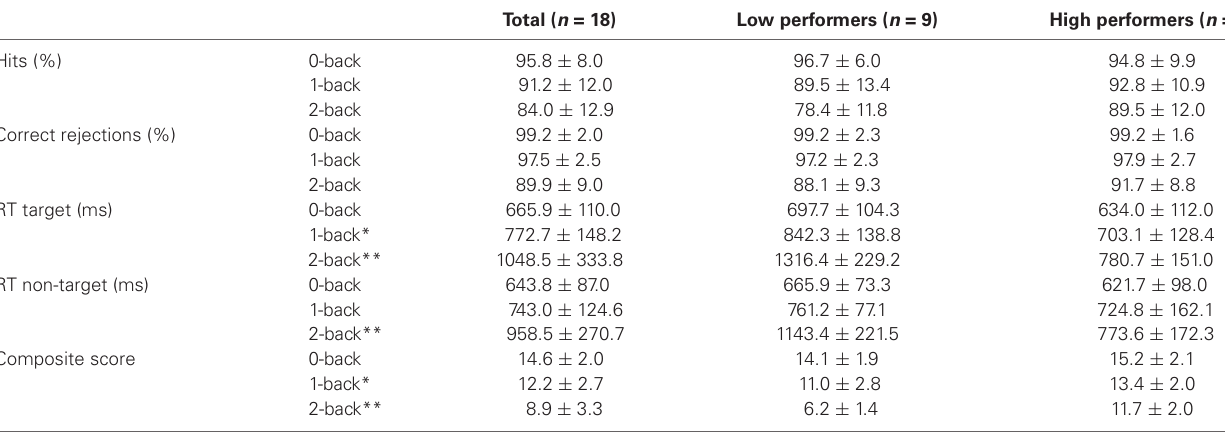
Table 2 | Accuracy and reaction times (Mean ± SD) for the spatial n-back tasks